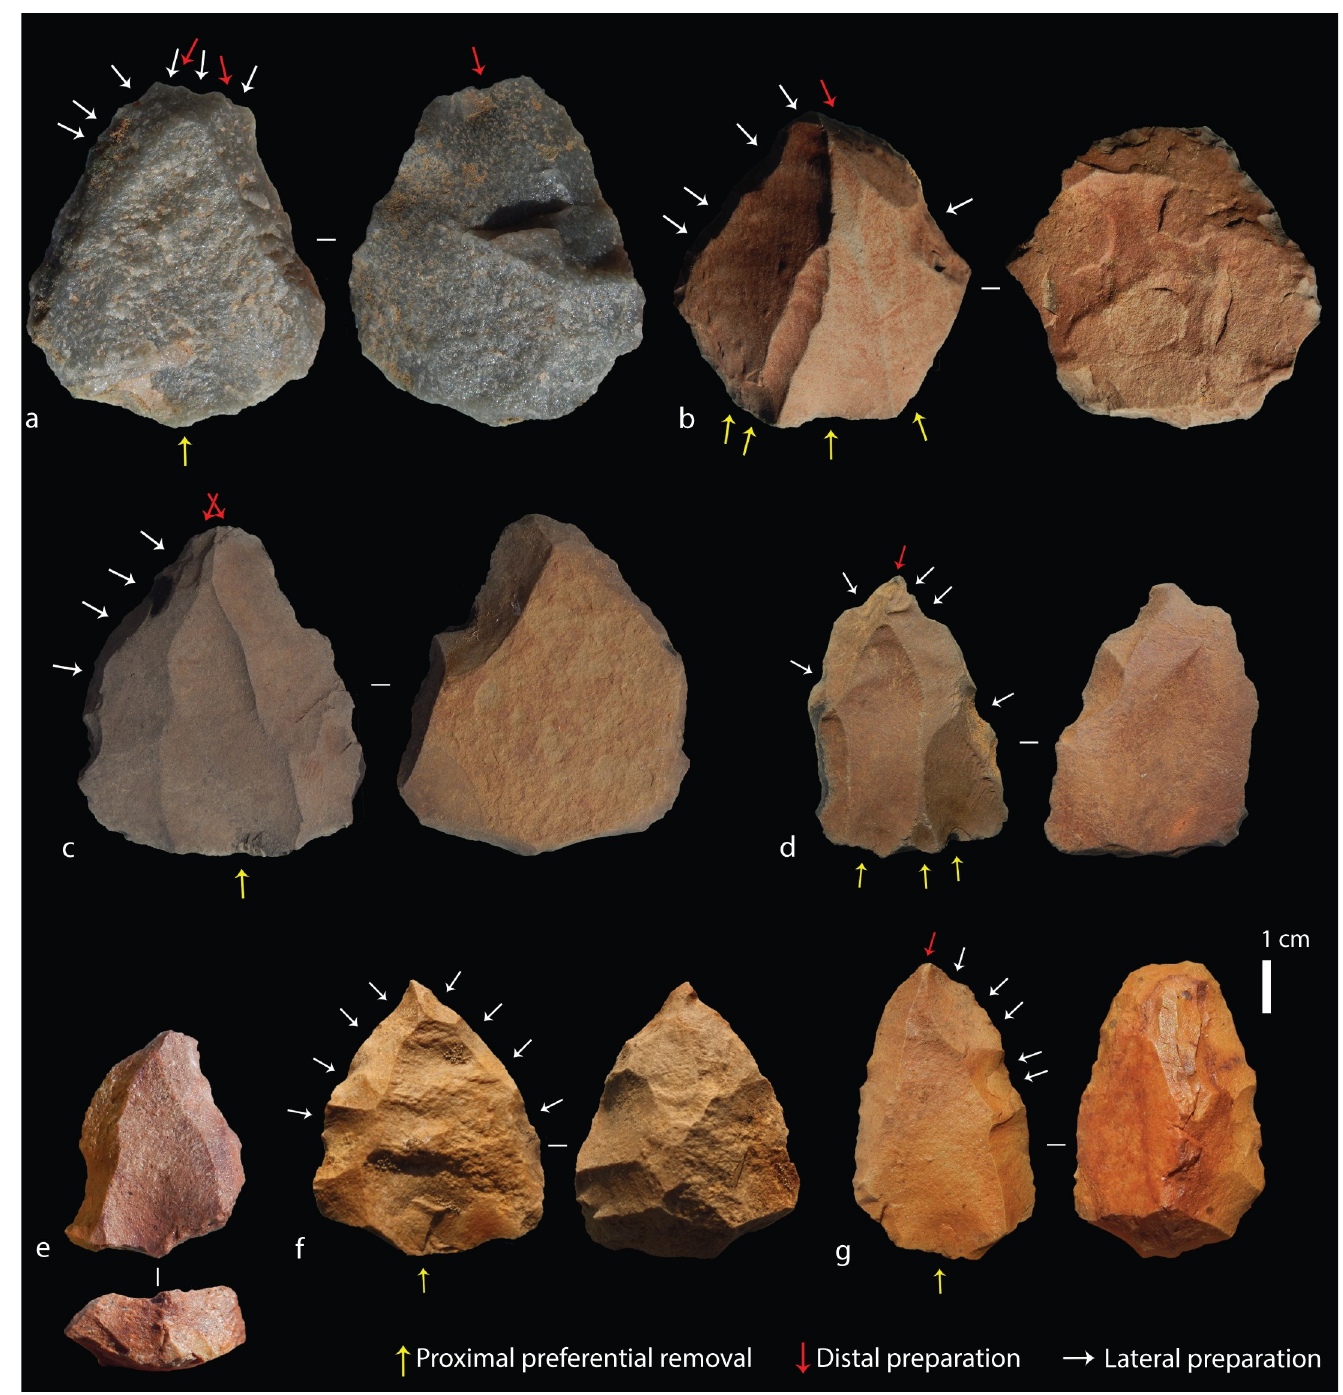
Fig 17. Nubian core surface finds in the Tankwa Karoo region. (a-d) Nubian cores; (e) point from Nubian core; (f) Olifants River core; (g) Bos River core. Raw material: (a) Dwyka quartzite, (b-d) hornfels, (e-g) silcrete. Locations of (a-e) shown in Fig 14 and (f-g) in Fig 1.